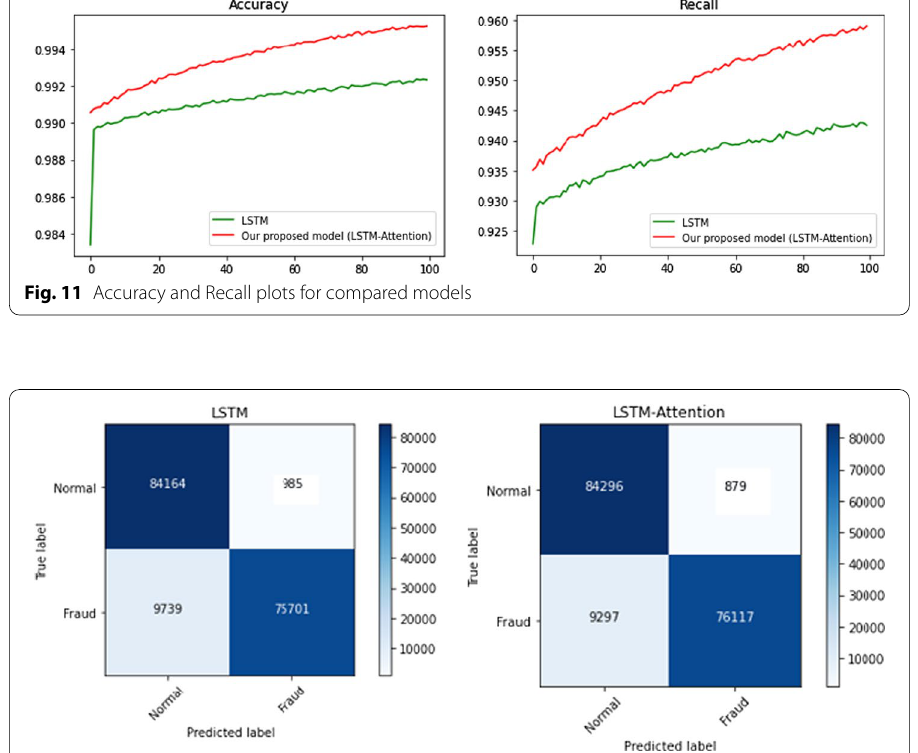
Fig. 12 Confusion matrices of LSTM and our proposed